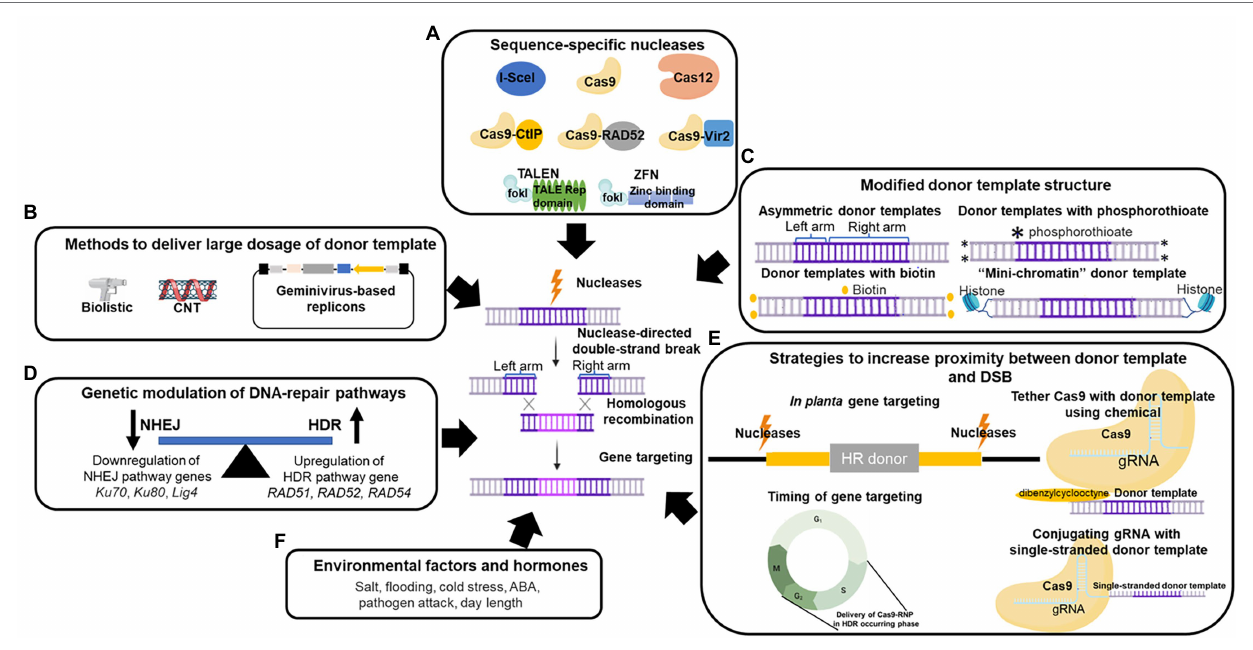
FIGURE 1 | Approaches for enhancing homologous recombination (HR) and gene targeting (GT) frequency in plants. (A) Sequence-specific nucleases can induce double-strand breaks (DSBs) at target loci. These nucleases include I-SceI, TALENs (TALE repetitive domain with FokI), ZFNs (Zinc-finger binding domain with FokI), Cas9, Cas12a, and Cas9 fusion proteins (Cas9-CtIP, Cas9-RAD52, and Cas9-Vir2). (B) Methods that can increase the dosage of donor templates in plants, encompassing biolistic, carbon nanotubes (CNTs), and geminivirus-based replicons (GVRs). (C) Modifications of donor template structure that result in higher HR efficiency. Altering the donor template symmetricity, labeling the 5 ′ or 3 ′ end of the donor template using phosphorothioate linkages or biotin, and attaching the donor template with histones as “mini-chromatin” can improve GT efficiency in plant cells. (D) Improved GT efficiency by genetic manipulation of the NHEJ and HR pathways. Knockout mutations in NHEJ pathway genes Ku70 , Ku80 , and Lig4, and the overexpression of HDR pathway genes RAD51 , RAD52 , and RAD54 can enhance HR efficiency in plants. (E) Strategies for bringing donor templates to target loci. These strategies include in planta gene targeting, delivery of the donor templates to the DSB during cell cycle phases when HDR occurs, conjugating the gRNA with the donor template, and attaching the donor template with the nuclease. (F) Environmental factors and hormones that alter HR efficiency. * Designates phosphorothioate modification at the end in donor